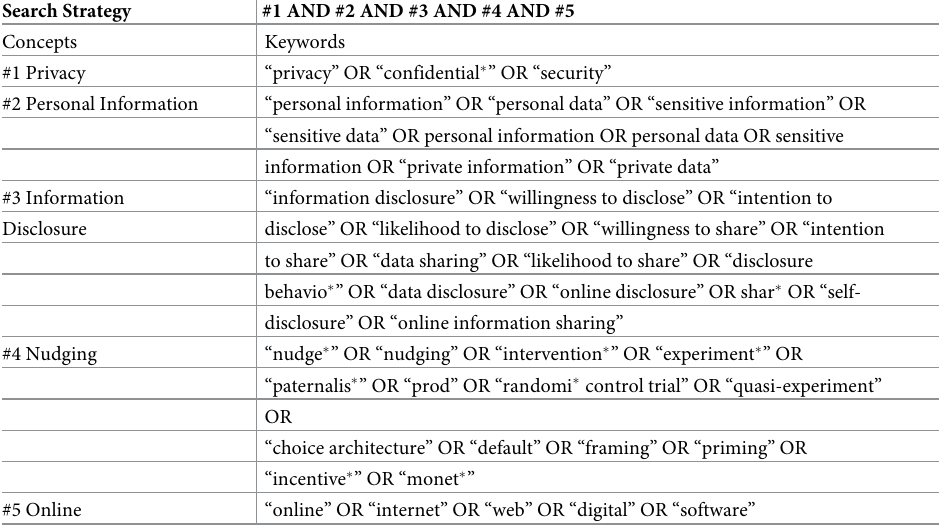
Table 1. Search strategy. Search